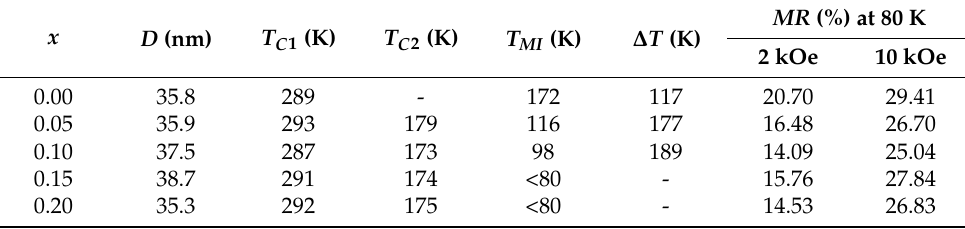
Table 2. The D , T MI , and MR (%) at 80 K for sample x = 0.00, 0.05, 0.10, 0.15 and